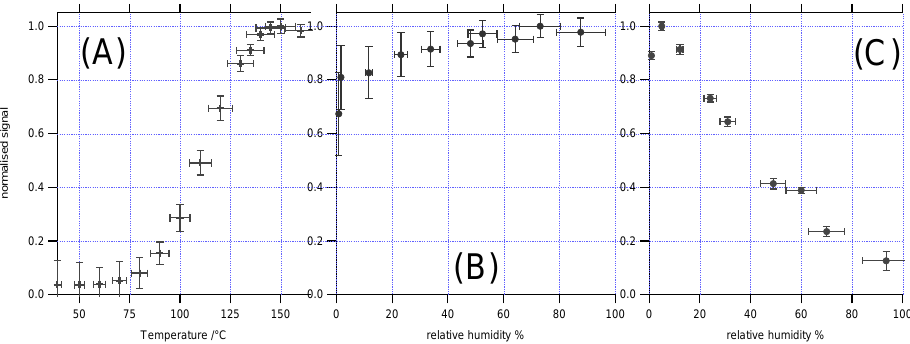
Fig. 2. (A) The dependence of the MPI ICIMS detection of PAN at m/z = 59 as function of thermal dissociation temperature. The uncertainty in the PAN signal is 1 σ and is a function of both the total signal and the subtraction of the background from the PAN source. The uncertainty in the temperature is given as 5%. (B) The normalised response of PAN vesus the relative humidity of the air sample. (C) The normalised response to PAA versus the relative humidity of the air sample. Uncertainty of the signal at m/z = 59 is shown as 1 σ and the uncertainty in relative humidity is